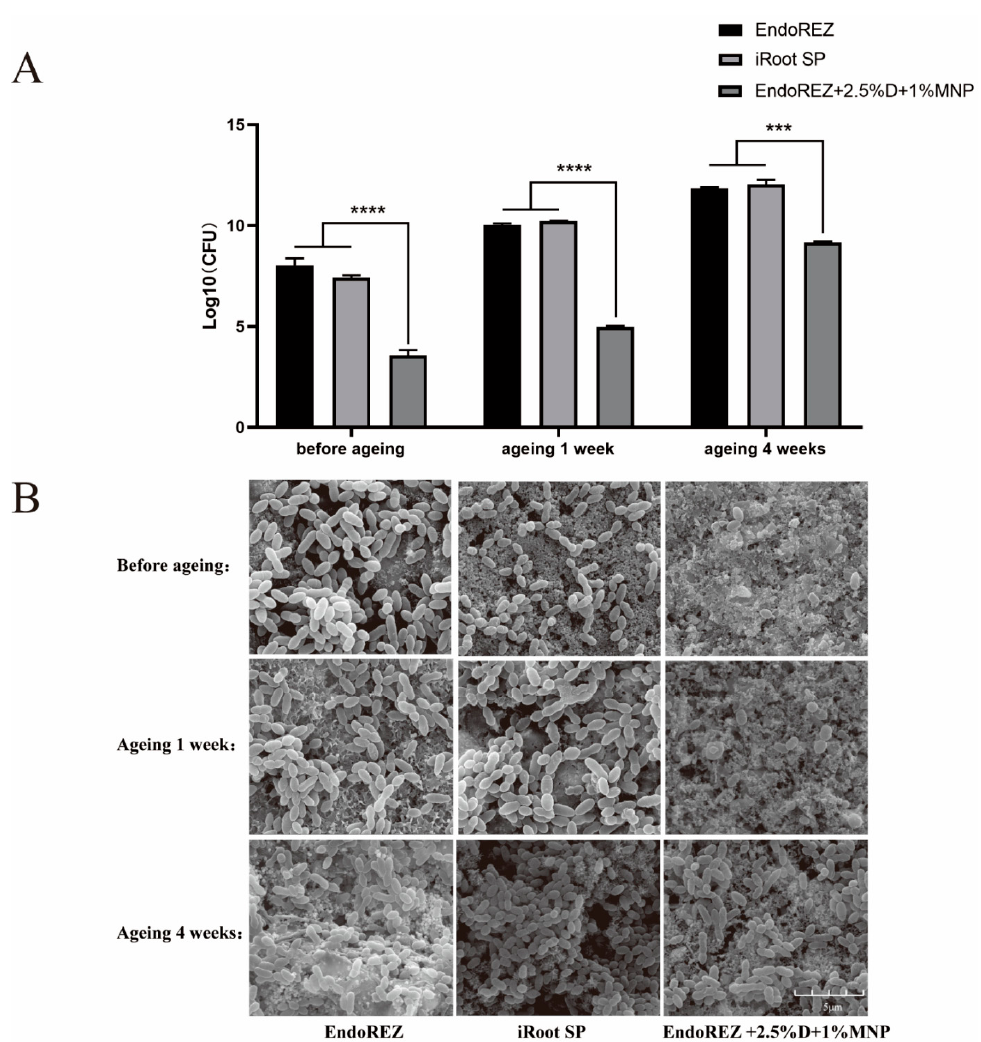
Figure 3. The long-term antimicrobial effects of three sealers. ( A ) Colony-forming unit counts of biofilms formed on each root canal sealer disk before aging, and after 1 and 4 weeks of aging. ( B ) Representative images of biofilms by scanning electron microscopy (SEM). Every value is